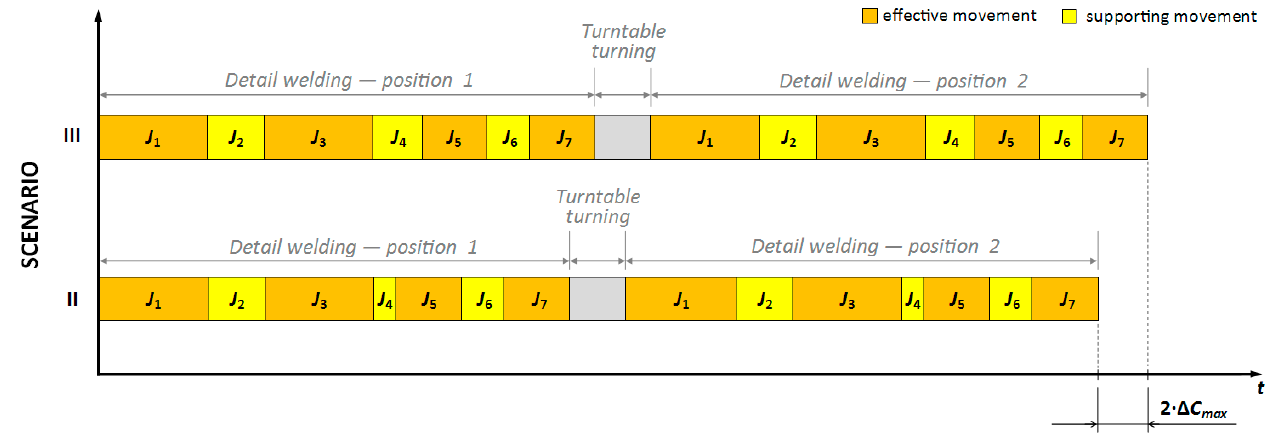
Figure 5. Schedules of the robot work throughout the entire process—comparison of the II and III scenario.